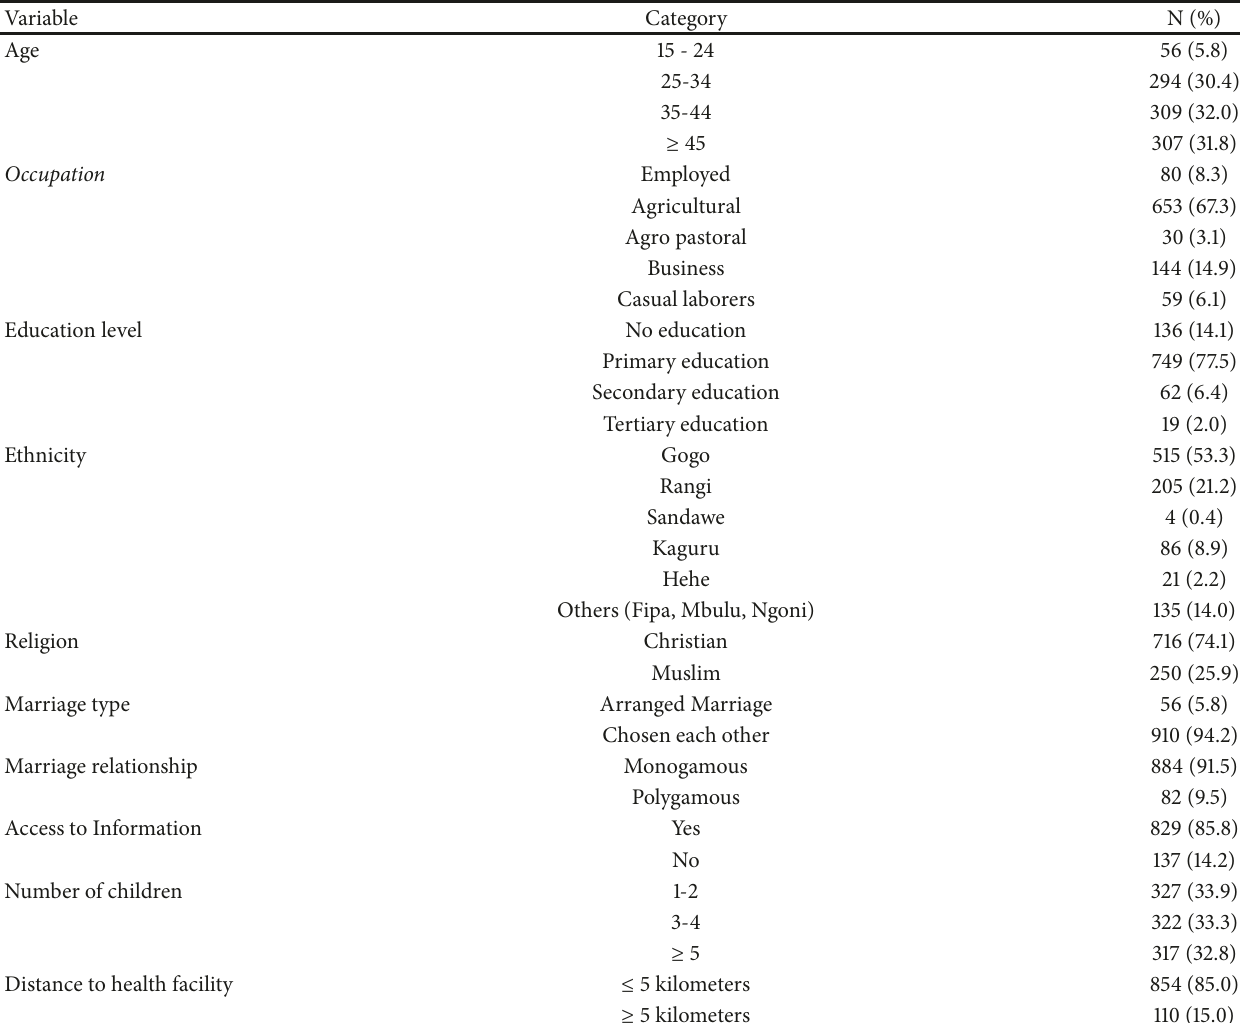
Table 1: Sociodemographic characteristics of respondents (N = 966).